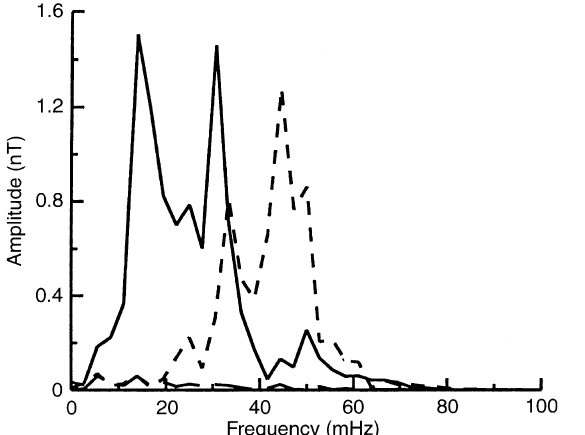
Fig. 3. Amplitude spectra of the time-series in Fig. 2; Pi2 signature ( solid line ), Pc3 pulsation ( short dashed line ), and insignificant activity ( long dashed line )